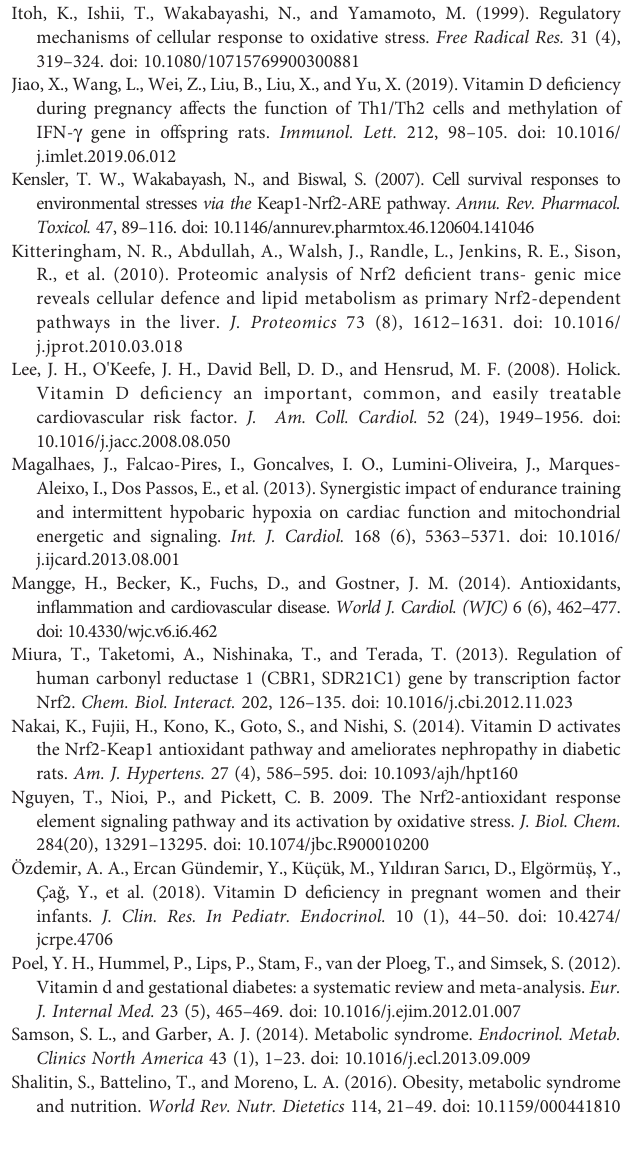
16. ** P < 0.01, * P < 0.05, vs. control group. Normal group, Con; maternal 25- hydroxyvitamin D de fi ciency group, VDD. SUPPLEMENTARY FIGURE 4 | Immunohistochemistry-positive staining signals of IL-1 b , IL-6 and TNF a were analyzed by Image J software. * P < 0.05, ** P < 0.01, vs. control group. Normal group, Con; maternal 25-hydroxyvitamin D de fi ciency group, VDD. SUPPLEMENTARY FIGURE 5 | The af fi rmation of Nrf2 inhibitor (Brusatol) concentration and the siCBR1 availability. (A) BRL cells were treated with Nrf2 inhibitor Brusatol at 0, 20, 40, 80, and 160 nM. The results from Western blot demonstrates the effect of Brusatol at various concentration on Nrf2 expression level. (B) Western blot analysis was performed to examine the protein levels of CBR1 in control (scrambled) siRNA- and CBR1-speci fi c siRNA using different siRNA (siCBR1-1, siCBR1-2, siCBR1-3)-transfected BRL cells. Densitometry dataforCBR1fromtheblotsshownwerenormalizedforanalysistoGAPDH.The results are expressed as mean ± SD of three independent determinations. ** P < 0.01, *** P < 0.001, vs. control group. Normal group, untreated group, Con; siCBR1-1, siC-1; siCBR1-2, siC-2; siCBR1-3,